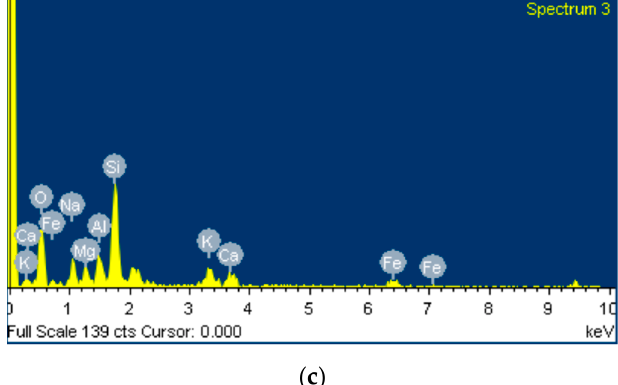
Figure 8. SEM micrographs of the optimum geopolymer synthesis ( a , b ) along with EDS analysis ( c ).